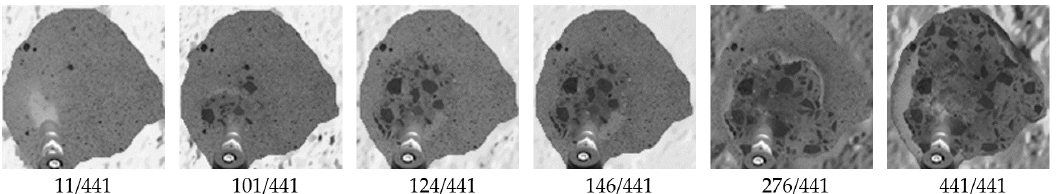
Figure 16. Spalling pattern for six points during fire exposure for the specimen with a size of 200 × 200 mm.